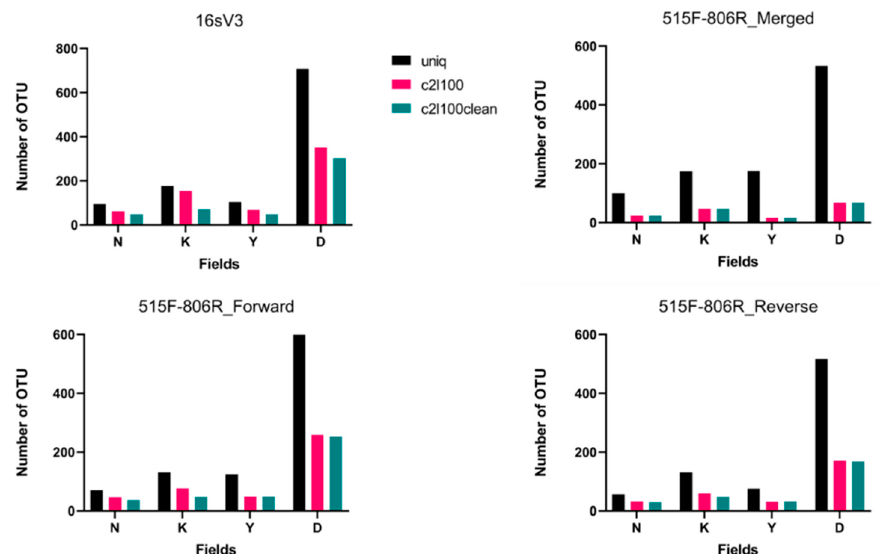
Figure 1. Number of OTUs detected in each fasta file. N, K, Y, and D represent Nev ş ehir-Kozakl ı , Ankara-K ı z ı lcahamam, Yozgat-Bo ğ azl ı yan, and Mu ğ la-Dalaman thermal springs respectively. Different colors represent bioinformatic filtrations: black is uniq, red is c2l100, and green is c2l100clean. Results belong to the pool of triplicate PCR pools of 4 field samples (12 in total).